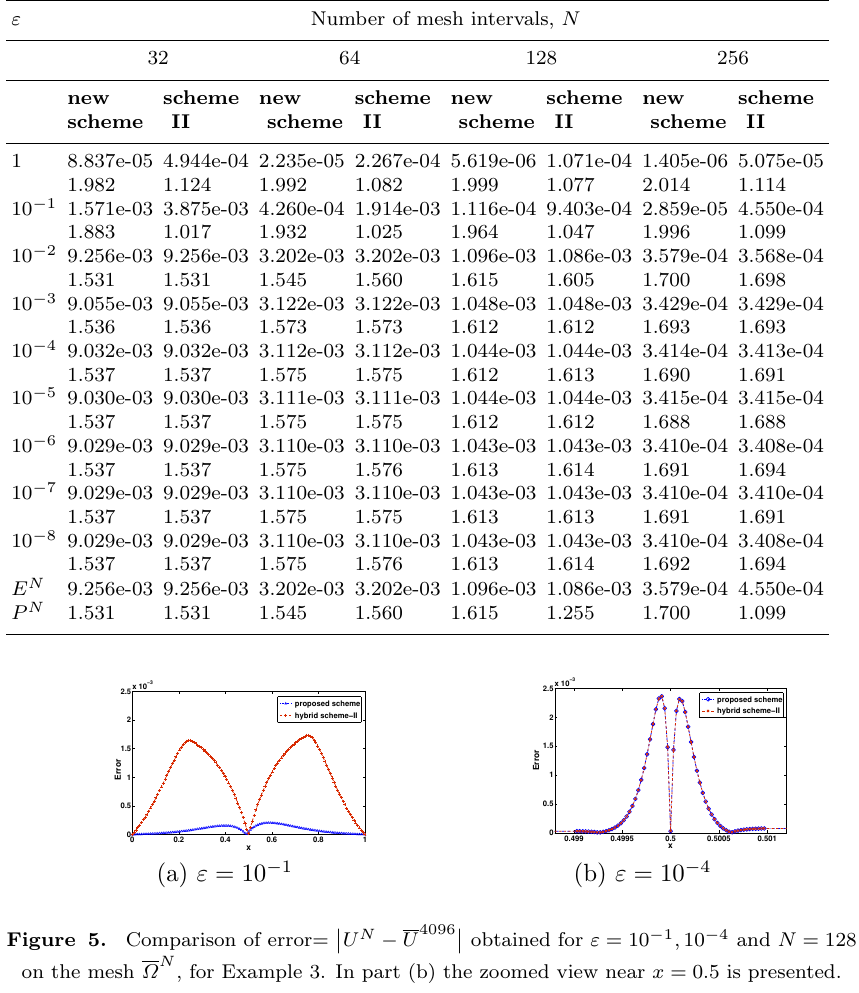
using both the hybrid schemes are depicted, respectively in Figures 4 and